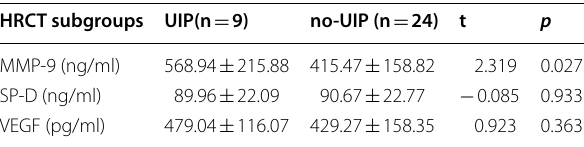
Table 5 Comparison of serum biomarker level and HRCT subgroups in the CTD-ILD patients